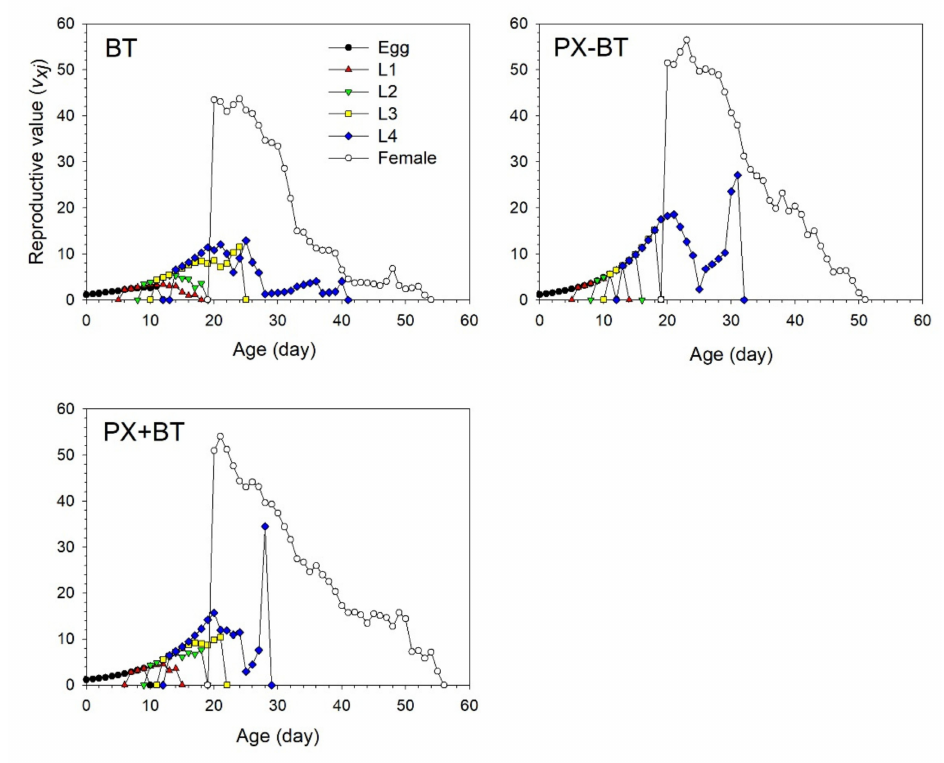
Figure 4. Age-stage specific reproductive value ( v xj ) of Bemisia tabaci when feeding on Chinese kale alone (BT), with prior Plutella xylostella damage (PX − BT) or with simultaneous P. xylostella damage (PX +